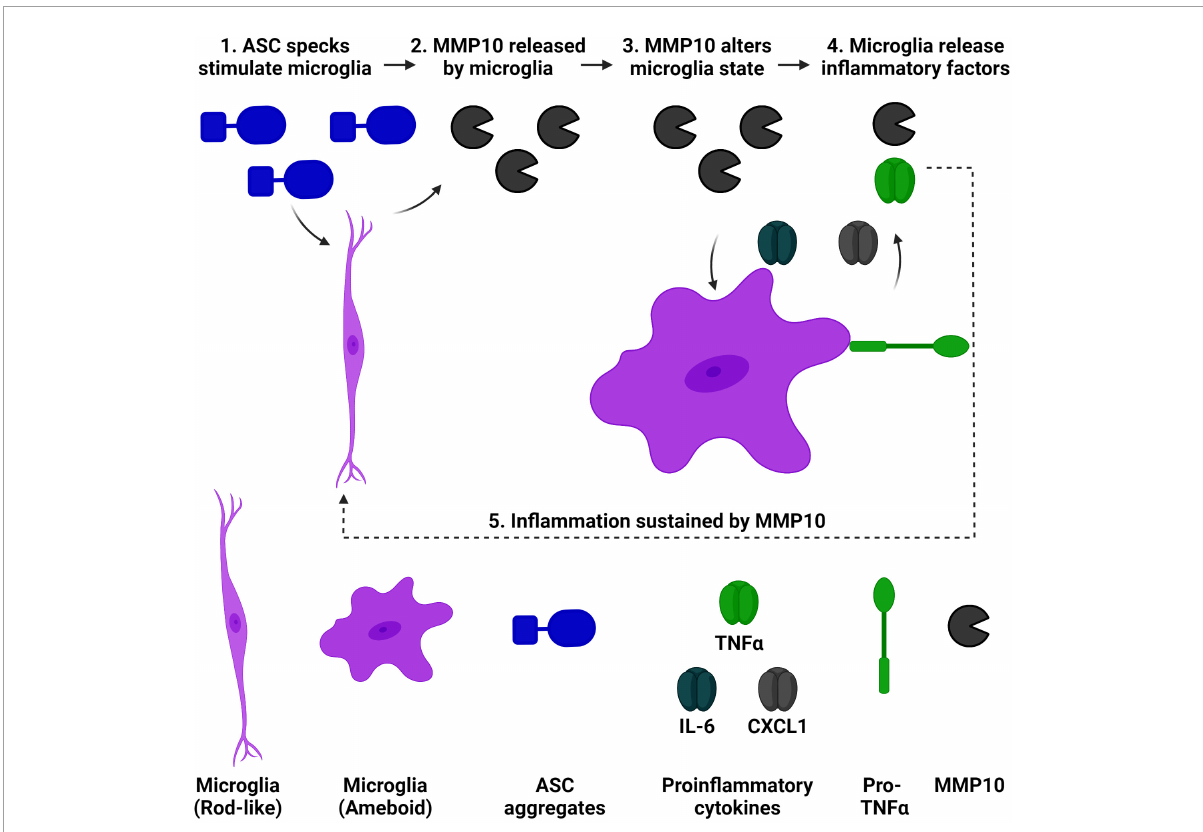
FIGURE6 ASC speck-mediated of release of MMP10 may perpetuate inflammation of microglia. We have established that ASC-speck aggregates can stimulate the release of MMP10 in primary microglia. As a result of exposure to MMP10, adjacent microglia will take on a pro-inflammatory state. This phenotype includes altered morphology and the release of inflammatory factors TNF α , IL-6, and CXCL1. In addition to classical proinflammatory cytokines, even more MMP10 is released so that it can act on adjacent microglia to continue the cycle of inflammation since IL-4 is not present. Taken together, these findings suggest that MMP10 perpetuates a chronic inflammatory state. Image created with BioRender.